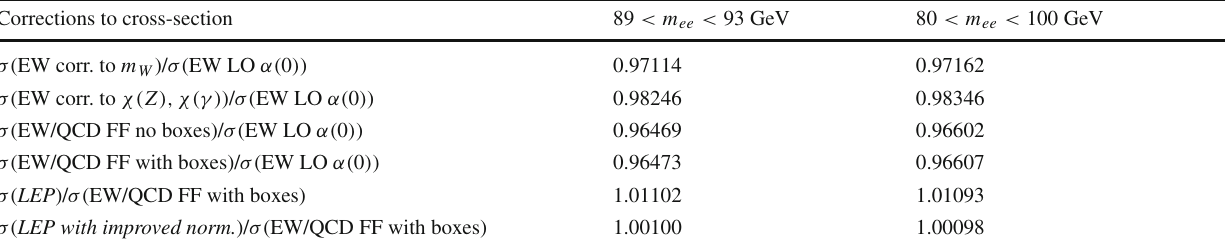
Table 3 EW corrections for cross-sections integrated over the specified mass windows. The EW weight is calculated with cos θ ∗